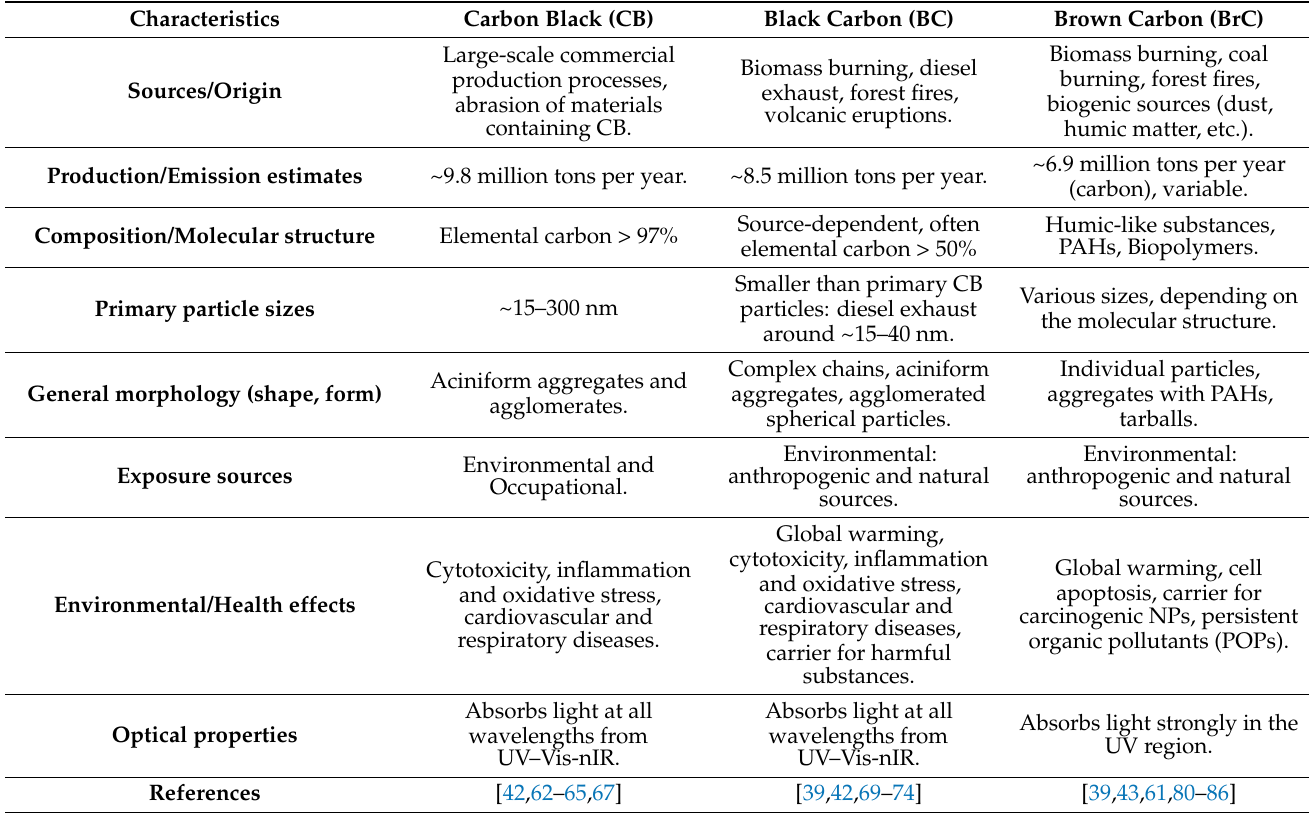
Table 1. Characteristics of CB, BC, and